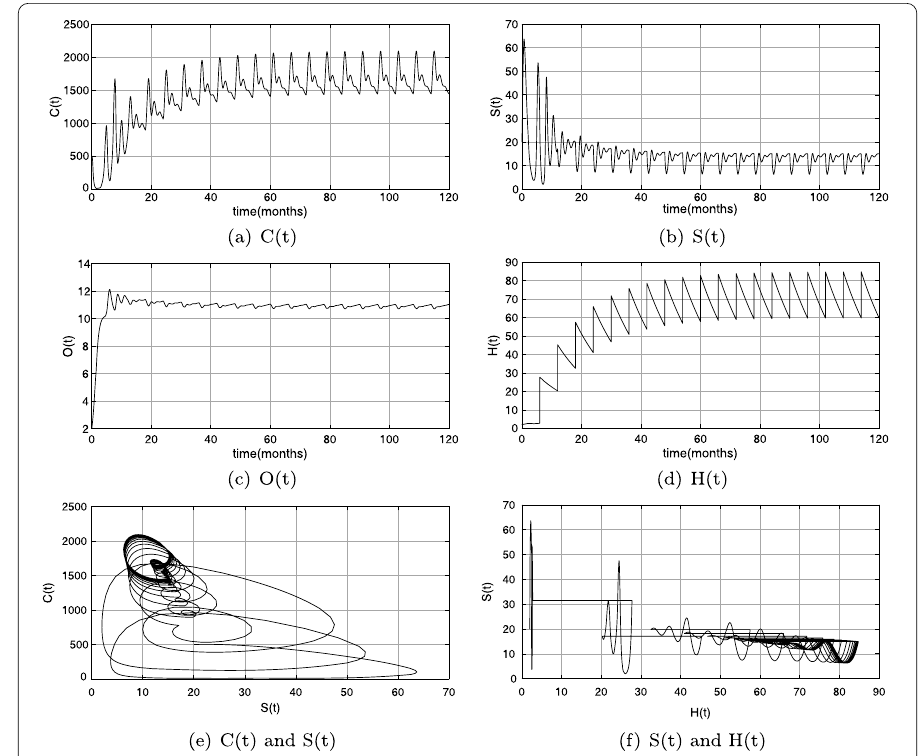
Figure 3 Strategy 3: C (0) = 500, S (0) = 20, O (0) = 2, H (0) = 2, h = 25, T = 6 ( a ) the dynamic of C ( t ), ( b ) the dynamic of S ( t ), ( c ) the dynamic of O ( t ), ( d ) the dynamic of H ( t ), ( e ) the dynamic of C ( t ) and S ( t ), ( f ) the dynamic of S ( t ) and H ( t